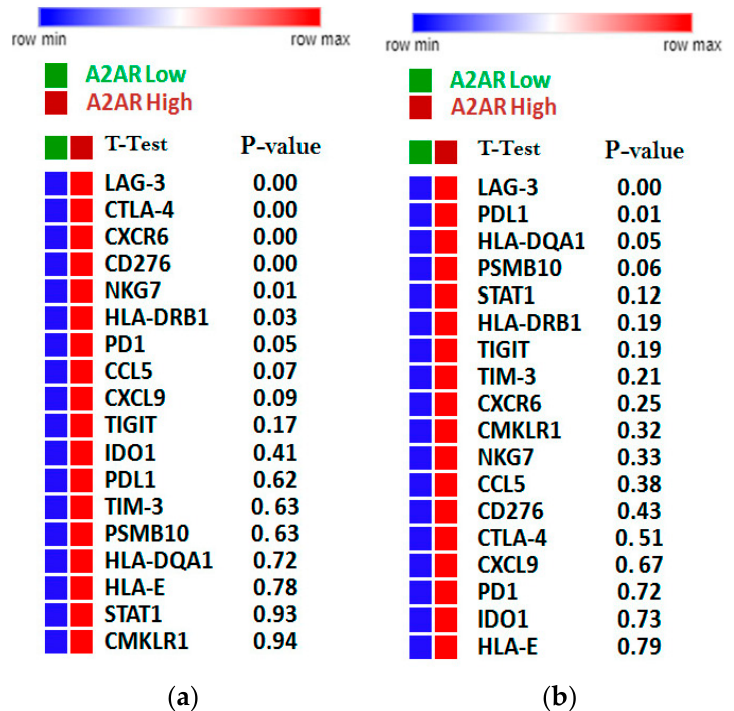
Figure 8. Correlation of A 2A R expression with lymphocyte exhaustion genes. ( a ) The CGGA male cohort; ( b ) The TGGA astrocytoma cohort. The more intense the red color, the stronger the gene expression; Green/orange color: Low A 2A R/High A 2A R.